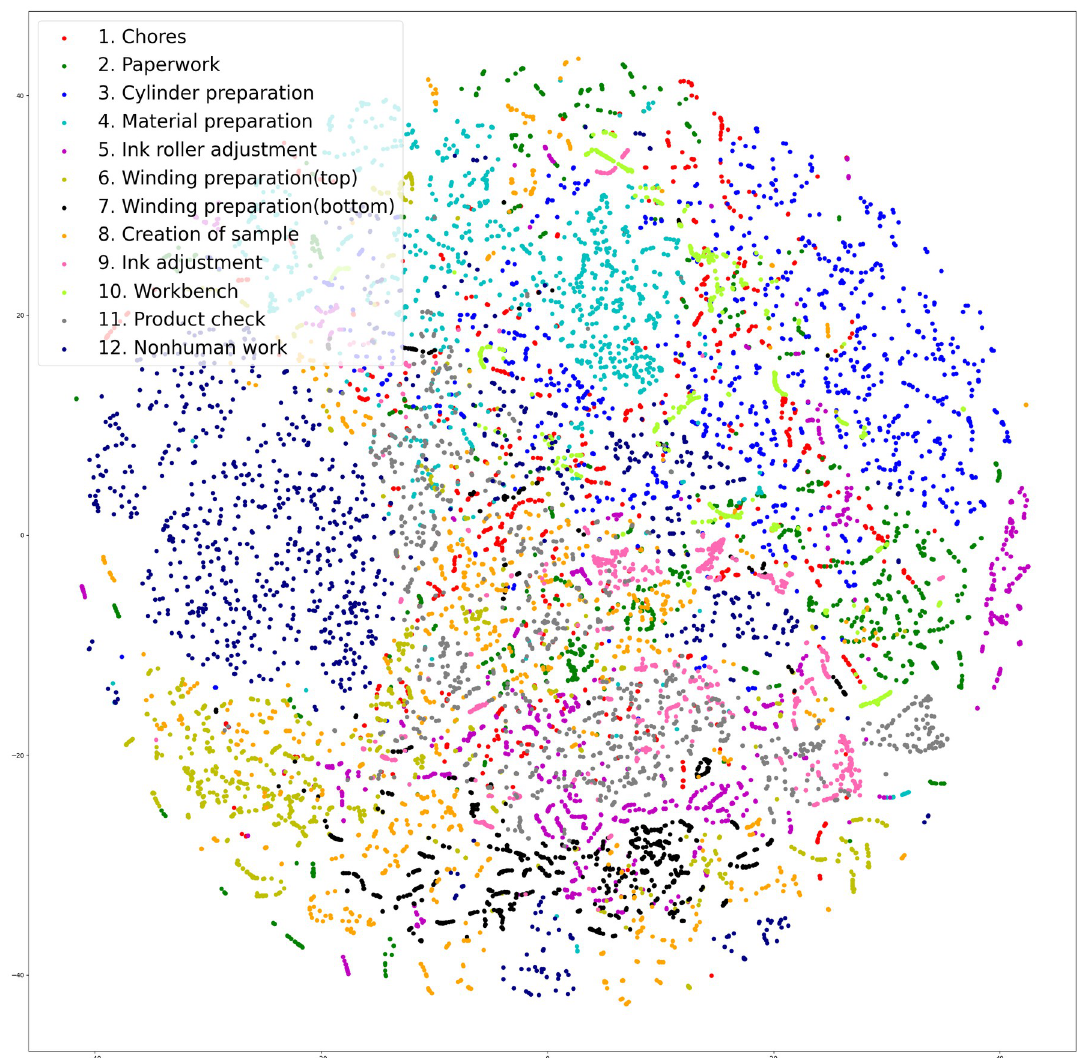
Fig 7. t-SNE of factory segmentation pre-trained CNN-LSTM outputs. (test